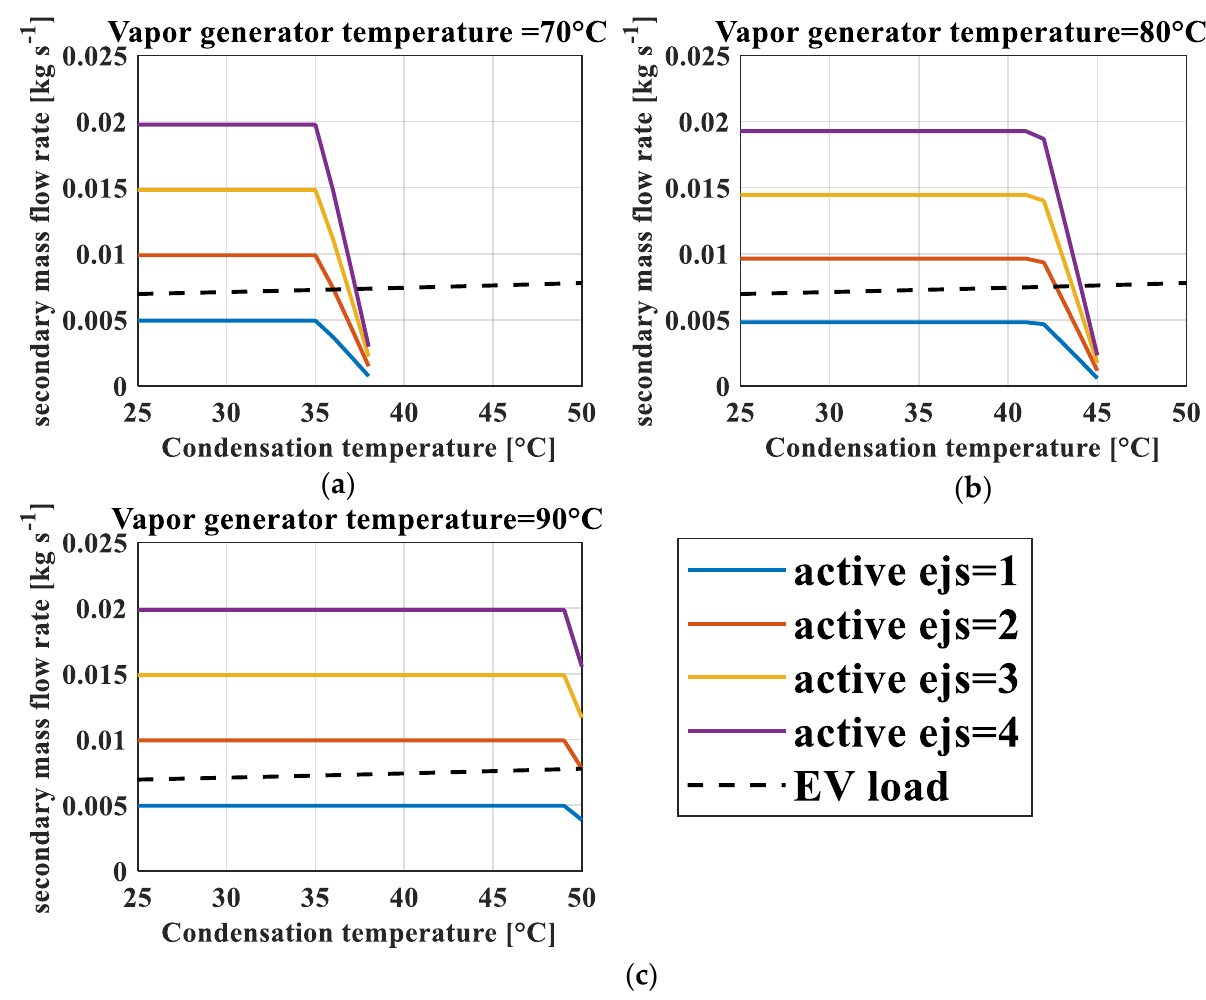
Figure 5. Example of multi-ejector control strategy assuming four ejectors with the same size at ( a ) T gv = 70 °C, ( b ) T gv = 80 °C, ( c ) T gv = 90 °C.